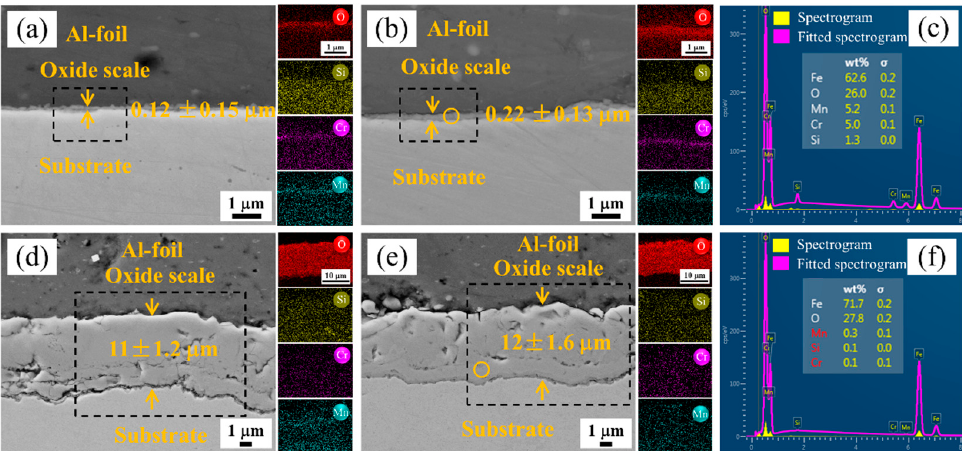
Figure 4. Cross-section morphology and EDS of the oxide of investigated and reference PHSs. ( a ) 1.2 GPa CF-PHS, ( b ) 1.7 GPa CF-PHS, ( c ) EDS point of oxide layers for 1.7 GPa CF-PHS, ( d ) 1.0 GPa bare PHS, ( e ) 1.5 GPa bare PHS, ( f ) EDS point of oxide layers for 1.5 GPa Al-Si bare PHS.